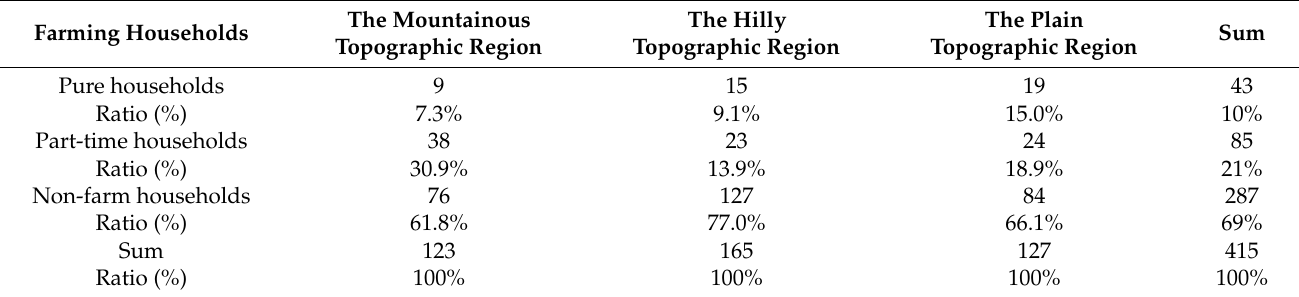
Table 5. Characteristics of diverse farming households in three topographic